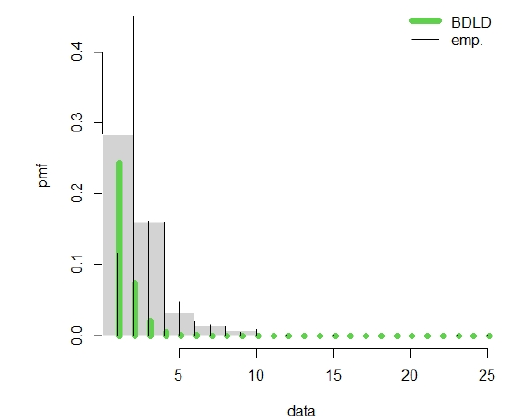
Figure 10. Fitted plot of Negative Binomial distributions for given data set . 5. Concluding Remarks A new one-parameter discrete distribution was proposed and its important distribu- tional, monotonic, and reliability characteristics were explored. Some statistical and relia- bility properties of the proposed discrete model were derived. Various estimating ap- proaches were discussed. A simulation study was conducted to determine the MLEs’ ac- curacy and precision. The applicability of the proposed distribution in modeling a real- life discrete data set was demonstrated. It is clear from the comparison that the new dis- tribution is the best distribution for fitting the data sets from among the all-tested distri- butions and it will be a useful contribution to the field of count data modeling. Author Contributions: Conceptualization, S.S. and S.K.; methodology, W.M.; software, J.G.; valida- tion, S.S. and S.K.; formal analysis, W.M.; investigation, S.S.; resources, F.J.; data curation, W.M.; writing—original draft preparation, S.S. and W.M.; writing—review and editing, S.K.; visualization, J.G.; supervision, S.K.; project administration, F.J. All authors have read and agreed to the published version of the manuscript. Funding: This research received no external funding. Conflicts of Interest: The authors declare no conflict of interest.